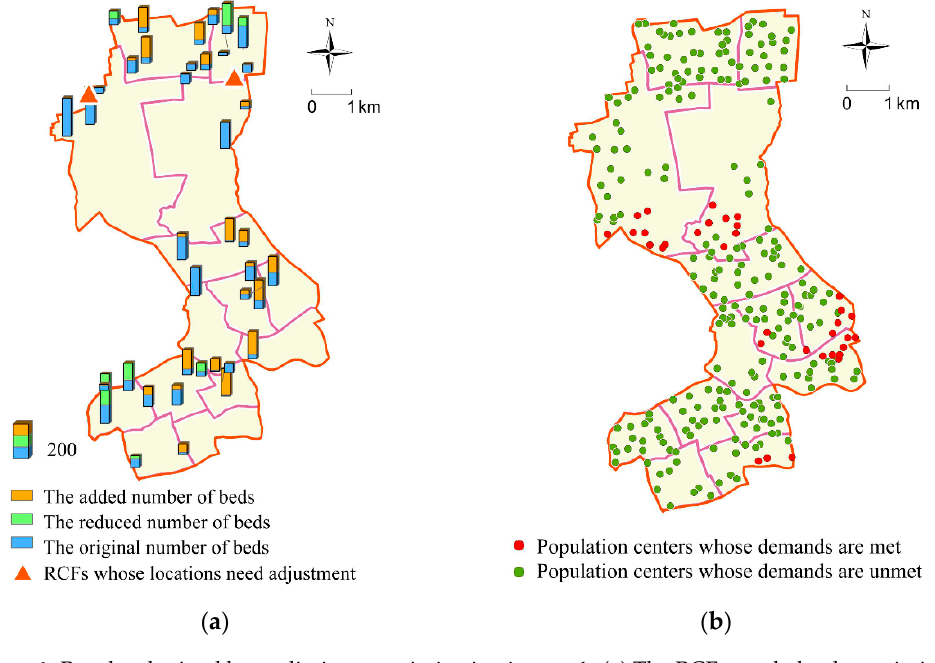
Figure 4. Results obtained by preliminary optimization in step 1. ( a ) The RCFs needed to be optimized; ( b ) the locations of population centers whose demands are met and unmet after preliminary optimization.